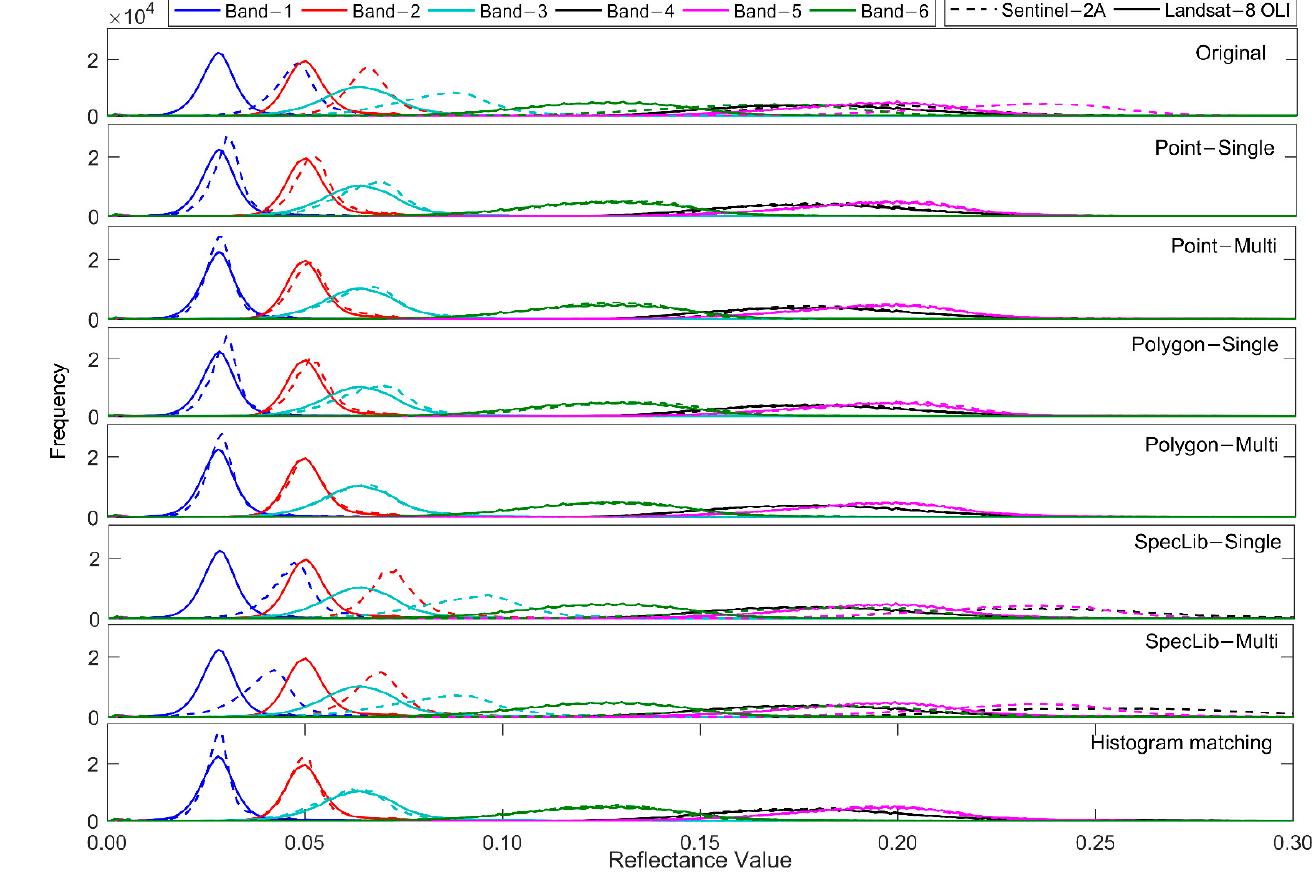
Figure 9. Reflectance frequency comparison of calibrated and reference images.